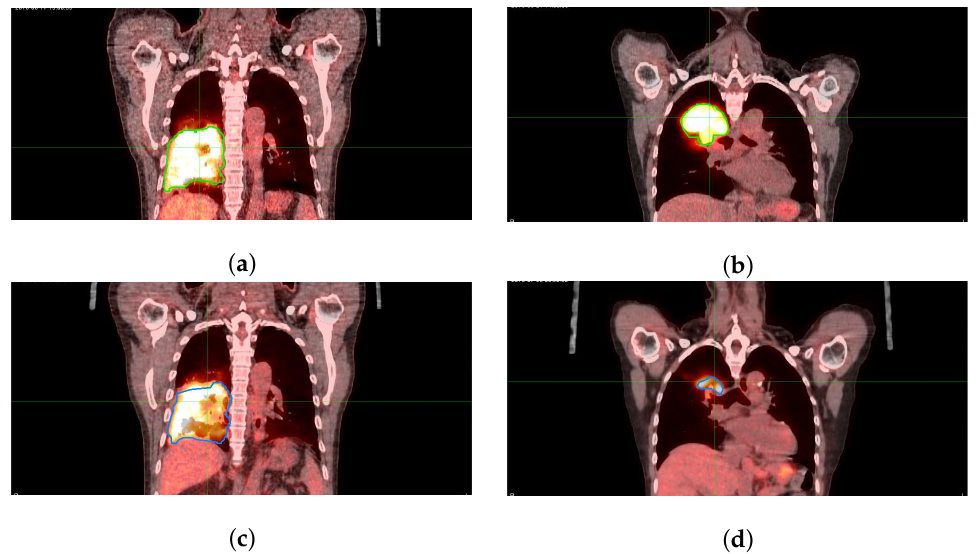
Figure 1. FDG-PET/CT images for an example PET non-responder patient ( a , c ) and PET responder patient ( b , d ), acquired pretreatment ( a , b ) and mid-treatment ( c , d ). Tumor volumes are displayed as blue/green